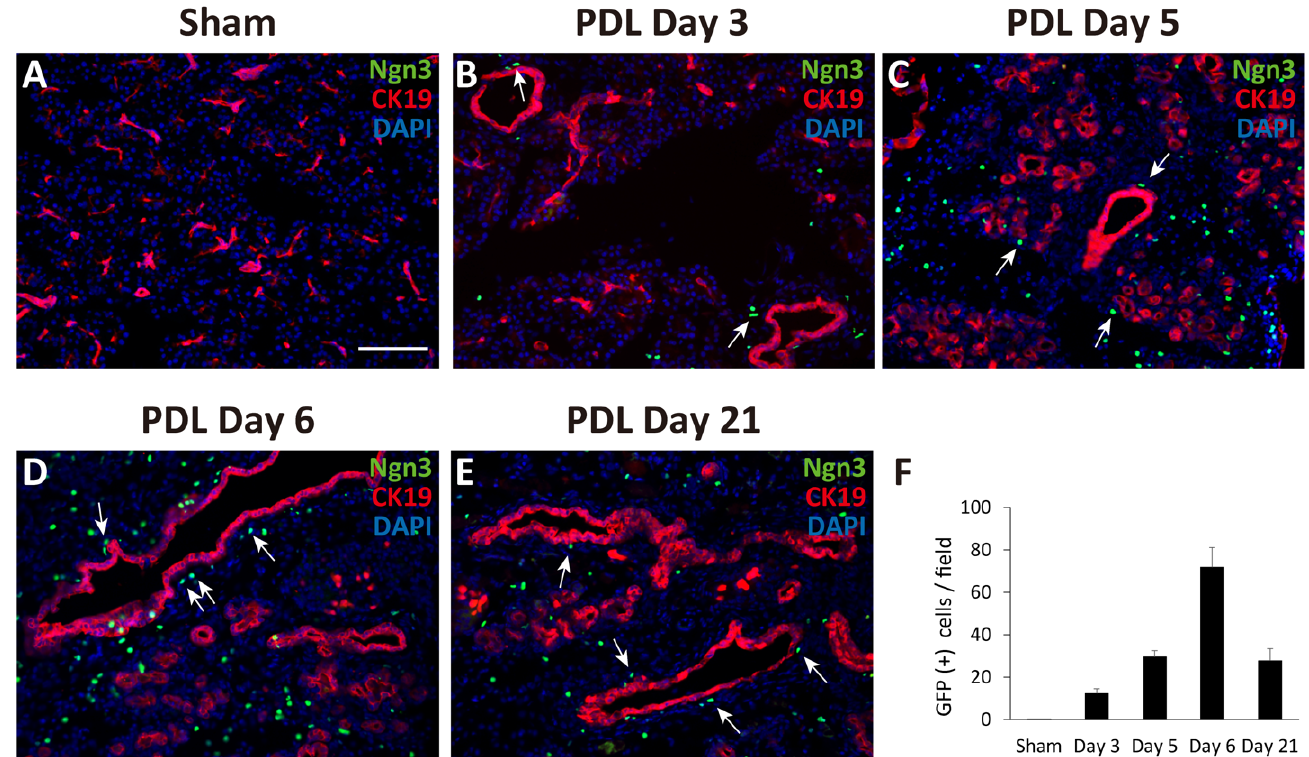
Figure 1. Monitoring GFP expression in pancreatic sections after partial duct ligation (PDL) using Ngn3-GFP transgenic mice. The tail region of the pancreas was ligated and examined for GFP expression using anti-GFP antibodies (green). Pancreatic ducts were identified using anti-CK19 antibodies (red). GFP expression was not detected in the sham-operated tail region of the pancreas ( A ). GFP signals appeared at around day 3 and gradually increased until day 6 after PDL surgery ( B – E ). The average number of GFP-positive cells in one micrograph is shown as a bar graph ( F , n = 3). Ngn3-positive cells were often detected proximal to CK19-positive ducts after PDL surgery (arrows) (bar: 100 µm).